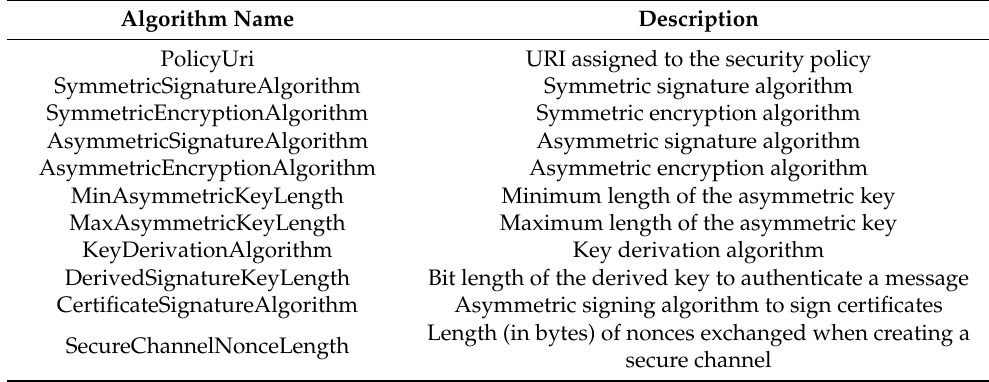
Table 19. OPC UA security policy